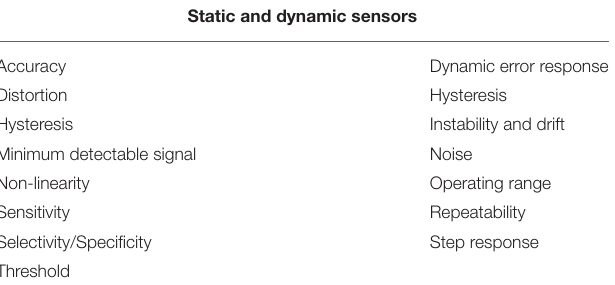
TABLE 2 | Sensor characteristics (National Research Council,